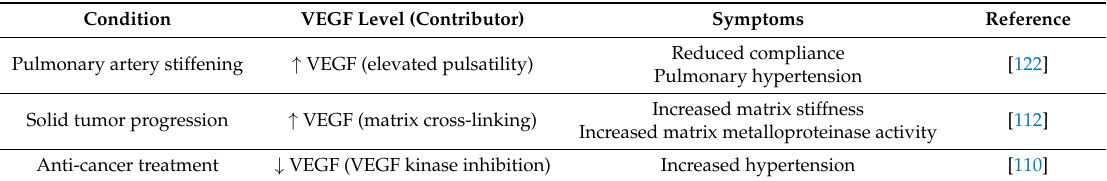
Table 3. VEGF signaling in vascular